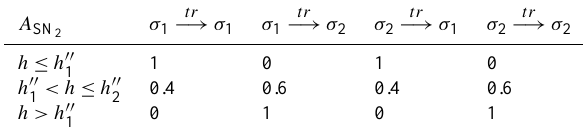
Table 4. Matrix of state-transition probabilities A SN